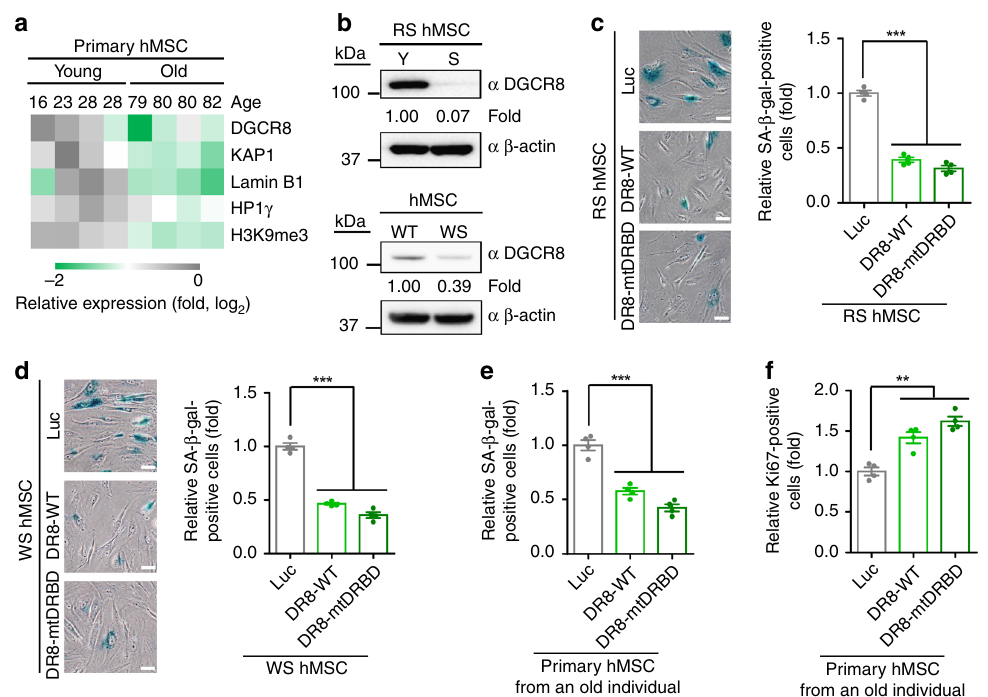
Fig. 6 DGCR8 is downregulated in senescent hMSCs and DGCR8 overexpression attenuates hMSC aging. a Heatmap showing the quanti fi cation of protein levels in young and old human primary MSCs. Expression levels of indicated proteins in old hMSCs were normalized to those in young hMSCs. b Western blotting analysis of DGCR8 in replicative senescent (RS) and WS hMSCs. Y, young, S, senescent. β -actin was used as the loading control. c SA- β -gal staining of RS hMSCs transduced with Luc, DR8-WT, or DR8-mtDRBD. Data were presented as mean ± SEM. n = 4 images per condition, *** p < 0.001. Scale bar, 20 μ m. d SA- β -gal staining of WS hMSCs transduced with Luc, DR8-WT, or DR8-mtDRBD. Data were presented as mean ± SEM. n = 4 images per condition, *** p < 0.001. Scale bar, 20 μ m. e SA- β -gal staining of primary hMSCs transduced with lentiviruses expressing Luc, DR8-WT, or DR8- mtDRBD. Data were presented as mean ± SEM. n = 4 images per condition, *** p < 0.001. f Ki67 staining of primary hMSCs transduced with